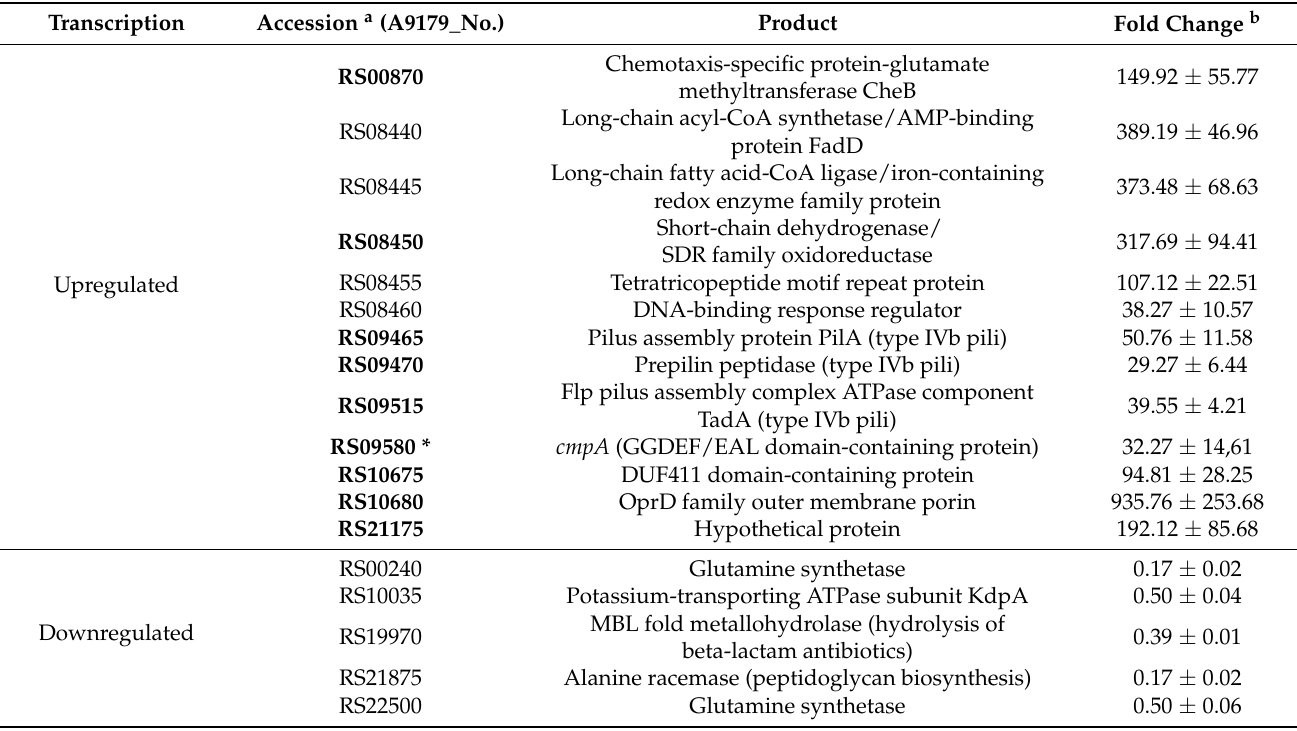
a Bold accession numbers (National Center for Biotechnology Information (NCBI)) indicate singleton P. alcaligenes AVO110 genes (see Figure 2), dotted lines separate gene clusters, * data previously reported [28]; b relative fold changes (normalized to housekeeping gene rpoD ) after 4 h in BM-RE relative to time zero. Values are means from three biological replicates with three technical replicates ± standard